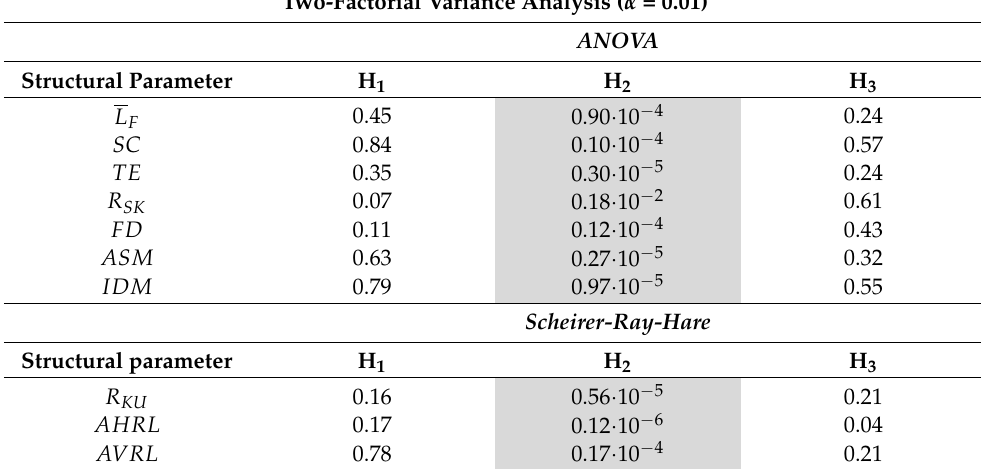
Table 3. Two-factorial variance analysis of the calculated structural biofilm parameters shown as p -values. p < α corresponds to a rejection of the hypothesis. H 1 : no difference in structural biofilm parameters due to flow velocities. H 2 : no differences caused by varied Fe 2+ concentrations. H 3 : no correlation between the two parameters c and u . It has to be noticed that hypotheses were tested for the biofilm structure acquired and analyzed at the end of the experiment (day 10). Two-Factorial Variance Analysis ( α =